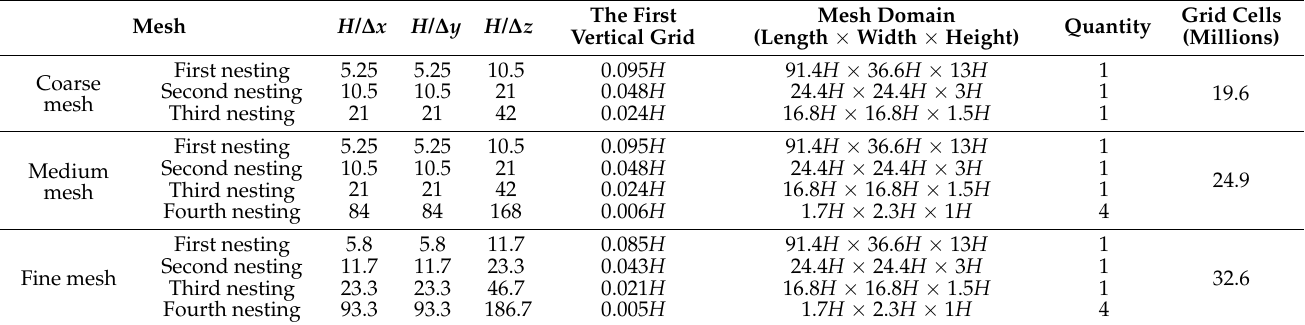
Table 1. Detailed configurations of nesting